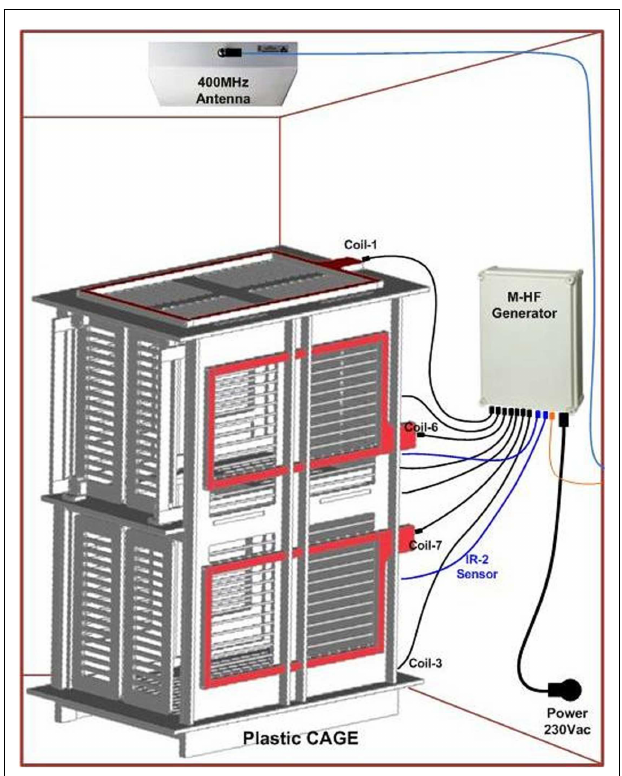
FIGURE 2 | System overviews a wireless recharge system for ECOGIW-16E